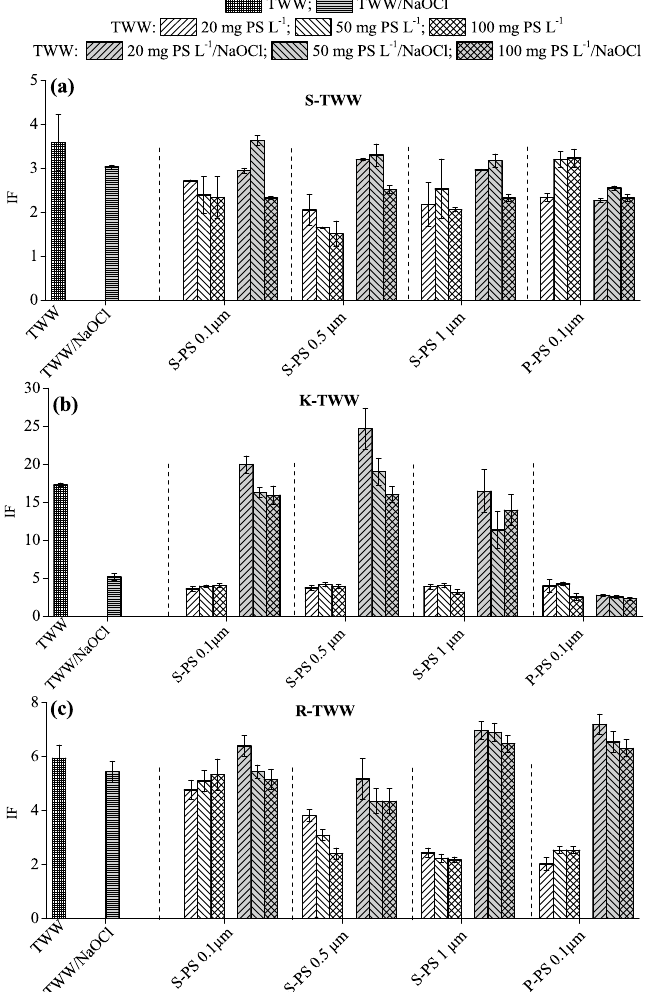
Figure 3. Cytotoxicity of TWW effluent samples and TWW-based suspensions of sulfate polystyrene (S-PS; 0.1, 0.5 and 1 µm) and pristine polystyrene (P-PS; 0.1 µm) particles at concentrations of 20, 50 and 100 mg L −1 before and after chlorination (20 mg L −1 of chlorine; by NaOCl). ( a ) Shafdan TWW effluent (S-TWW), ( b ) Karmi ′ el TWW effluent (K-TWW), ( c ) Raanana TWW effluent (R-TWW). S-TWW/NaOCl, R-TWW/NaOCl and K-TWW/NaOCl correspond to the chlorinated (20 mg L −1 of chlorine) TWW effluents. The error bars represent one standard